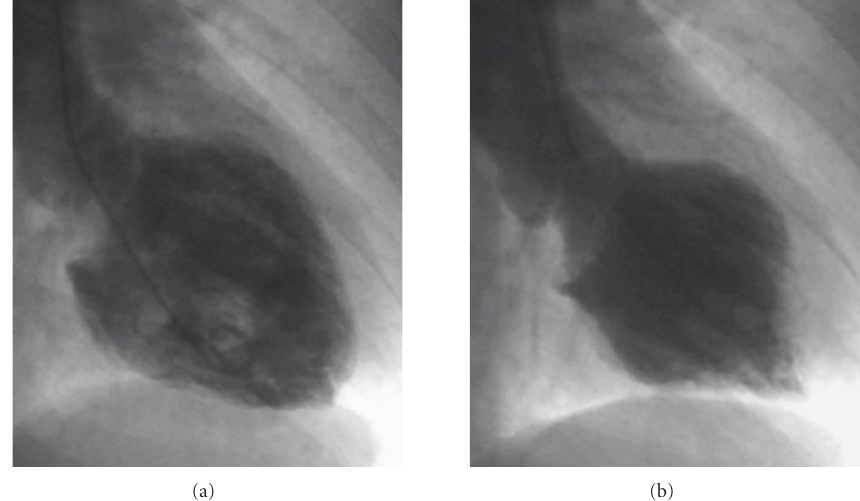
Figure 1: Ventriculography confirmed a global severe reduction of the systolic function (EF 28%) and apical hyperkinesis and severe dysfunction of the basal segments; (a) diastole, (b) systole.